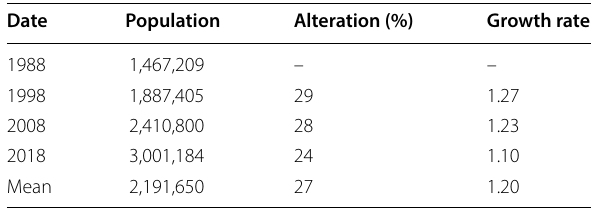
Table 3 Urban population in the study area based the